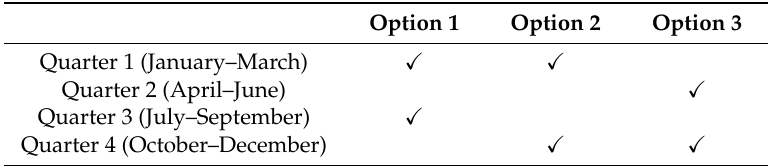
Table 2. Minimum requirement for the temporal distribution of the user’s tweets ( (cid:88) = At least one tweet in that period. Tweeting activity in the other two quarters of the year are